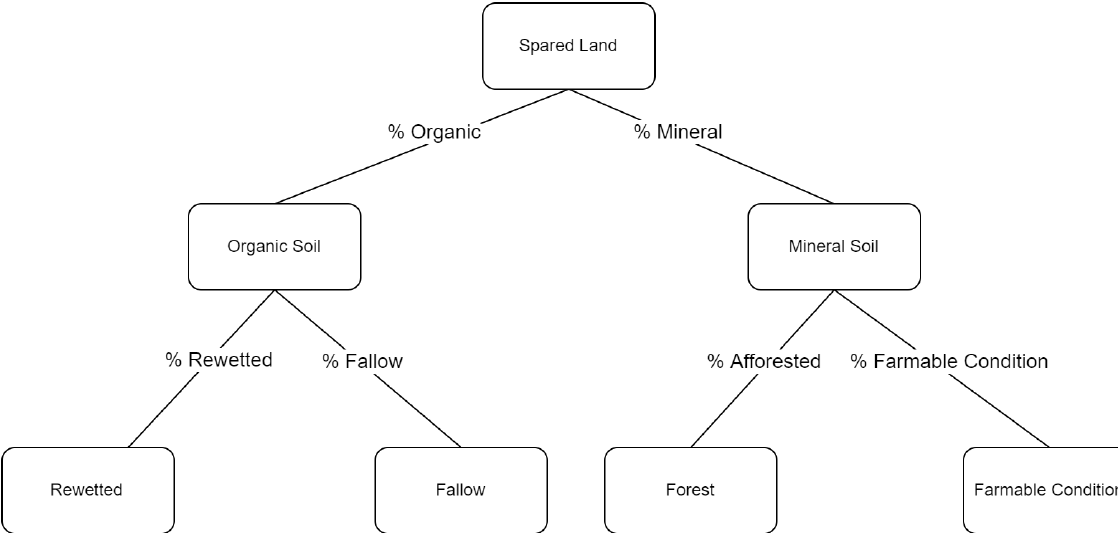
Figure 4. Allocation of spared land across different primary